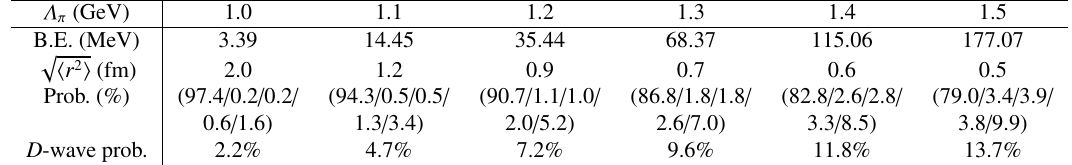
Table 6. Binding energy (B.E.), root-mean-square (RMS) radius, and probability at individual channels with 5-channel contributions.